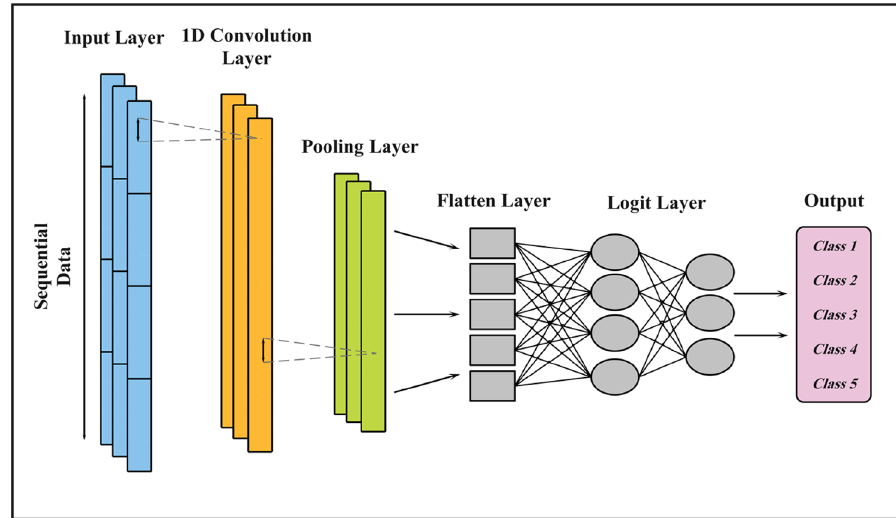
Fig. 7 Generic configuration of a convolutional neural network